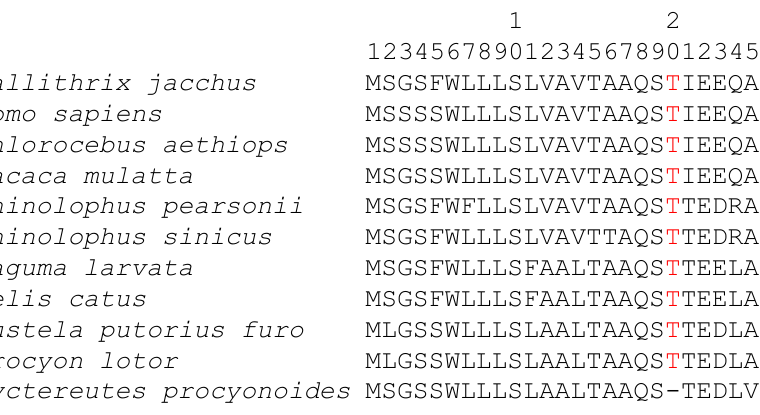
Figure 1. Multiple sequence alignment of 11 mammalian ACE2 proteins. Only 25 amino acid sites from the N-terminus are shown, taken from Wei et al. [14].